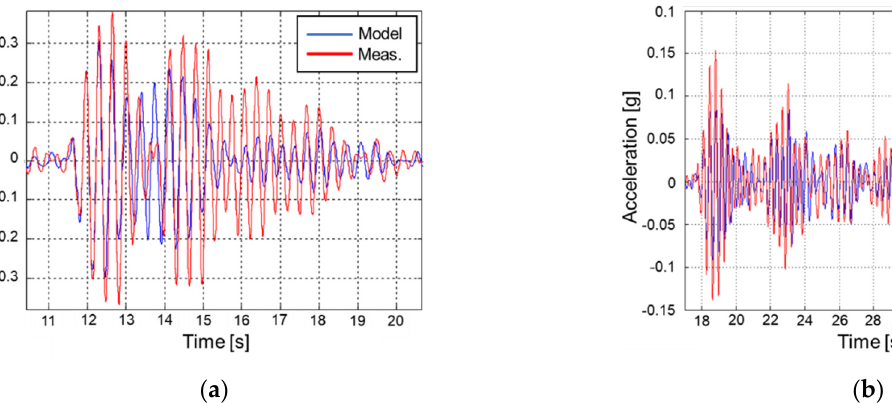
Figure 7. ( a ) Recorded on-site acceleration measurements and model accelerations on 16th story for model 12, excited by event 12, on sensor 14. ( b ) Recorded on-site acceleration measurements and model accelerations on 16th story for model 40, excited by event 72 on sensor 14.